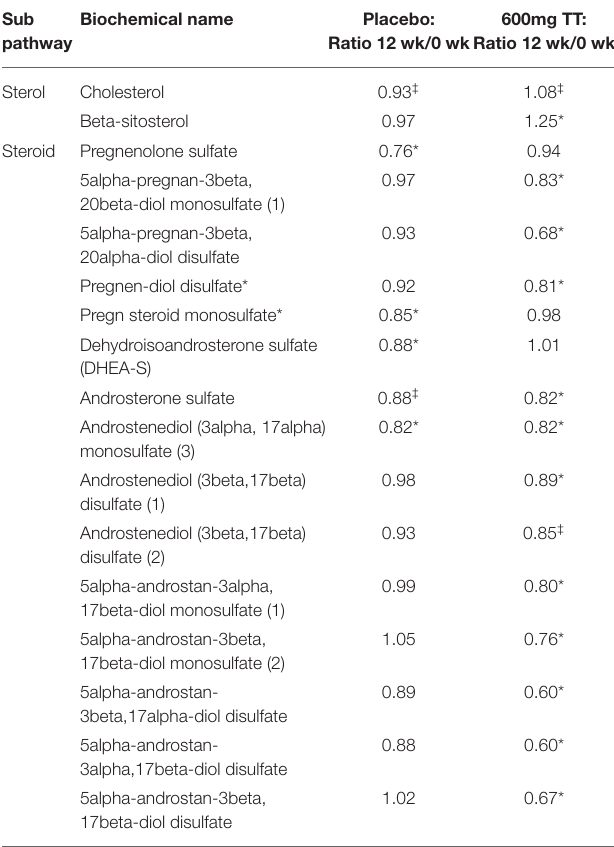
TABLE 4 | Changes in metabolites associated with steroid hormone metabolism in serum of the Placebo and the 600mg TT groups at 0 and 12 wk. Sub Biochemical name pathway